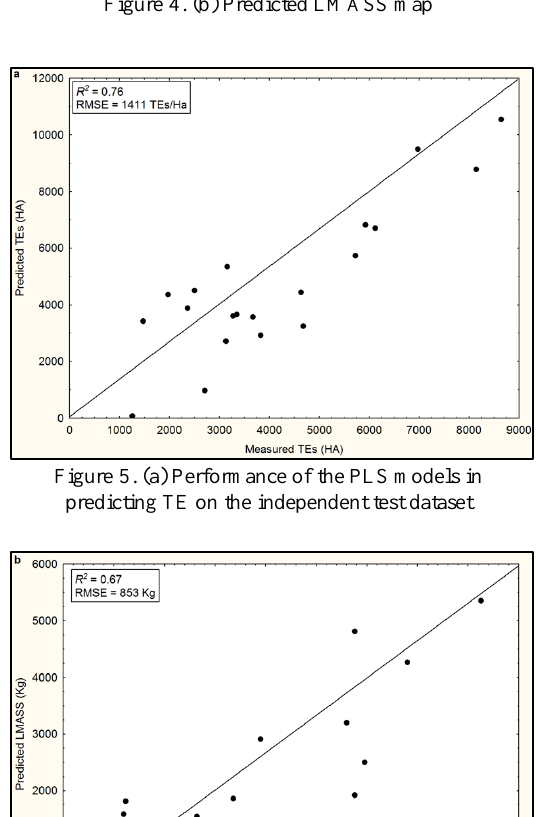
Figure 4. (b) Predicted LMASS map